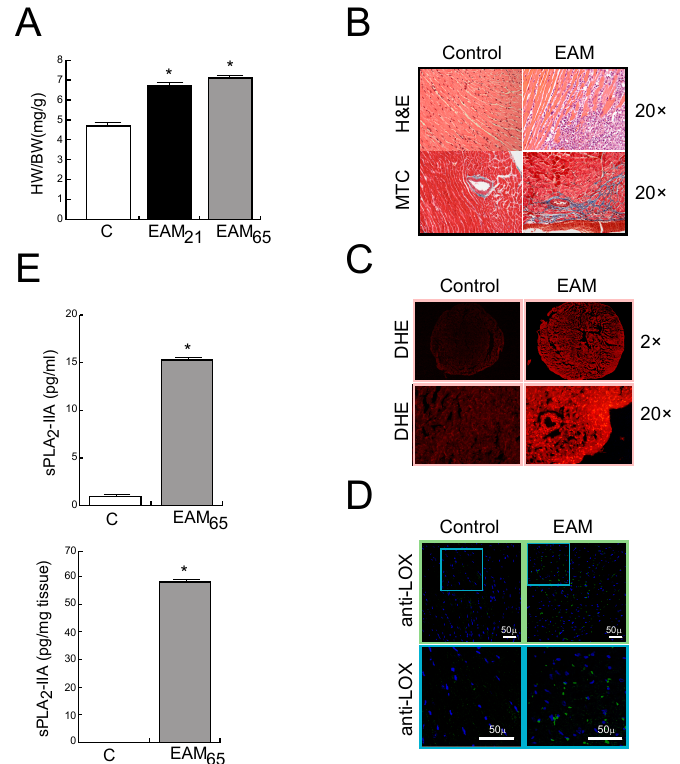
Figure 1. BALB / c mice were immunised with the MyCH α 614–629 peptide. ( A ) Heart weight (HW) / body weight (BW) ratio of mice sacrificed 21 or 65 days after initial immunisation. ( B – D ) Representative photomicrographs of heart sections from control and EAM mice on day 65: ( B ) H&E and MTC stain, ( C ) DHE stain (for detection of O 2 − ), and ( D ) LOX immunohistochemistry. Objective lens 2 × and 20 × , magnification 20 × and 200 × , respectively. ( C ) sPLA 2 -IIA protein levels on sera and heart tissue from control and EAM mice on day 65. Values are means ± SD. * p < 0.001 versus control mice, n = 7 in each group.